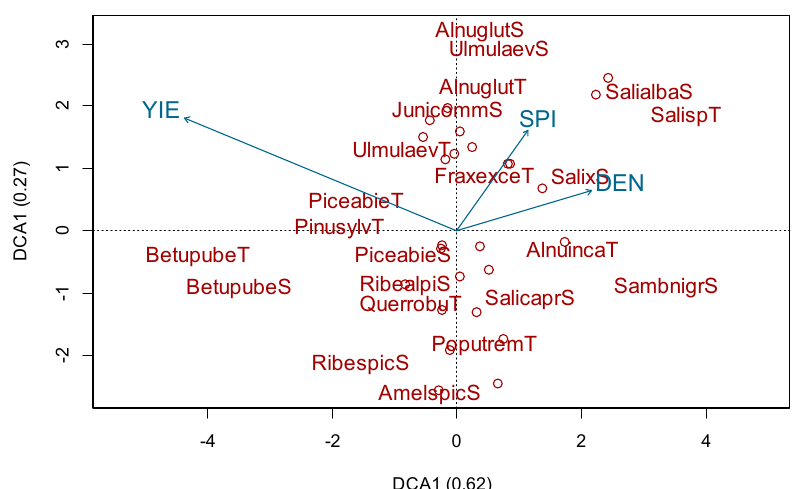
Figure 3. Grouping of tree and shrub species: results of detrended correspondence analysis. Analyzed factors: density (DEN), stream power index (SPI), total yeld (YIE). Letters “T” and “S” at the end of words represent the tree or shrub layer that they were classified into.